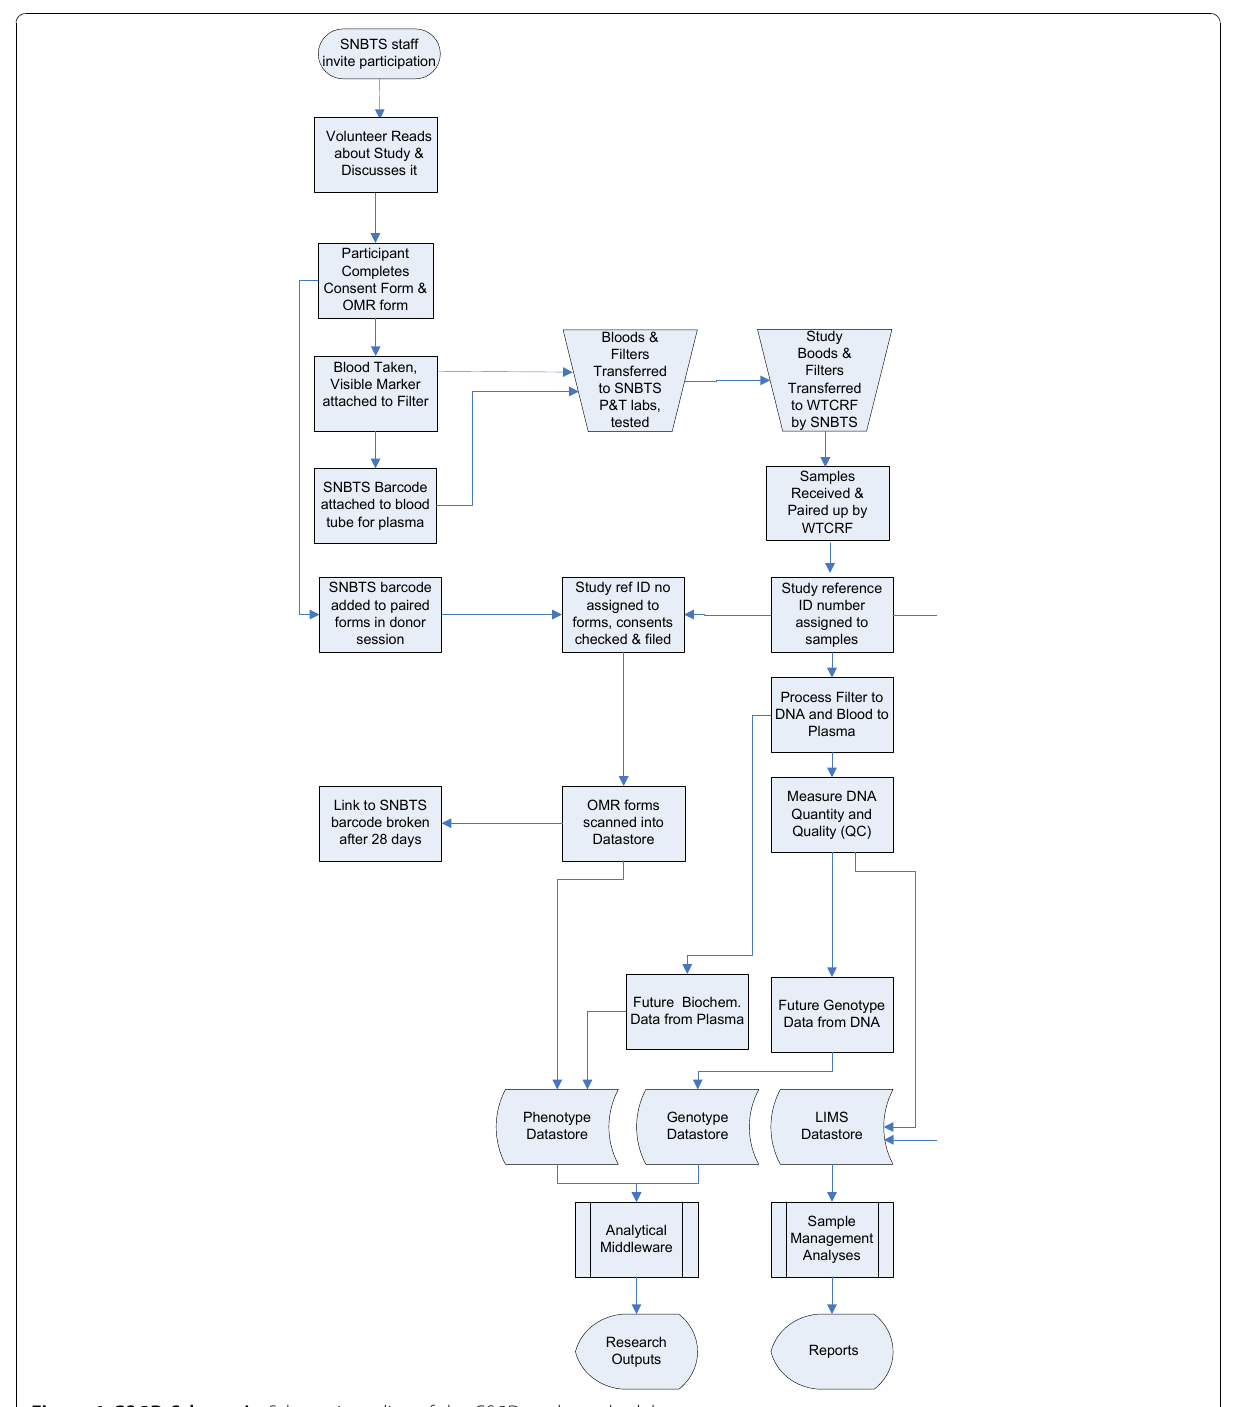
Figure 1 GS:3D Schematic . Schematic outline of the GS:3D study